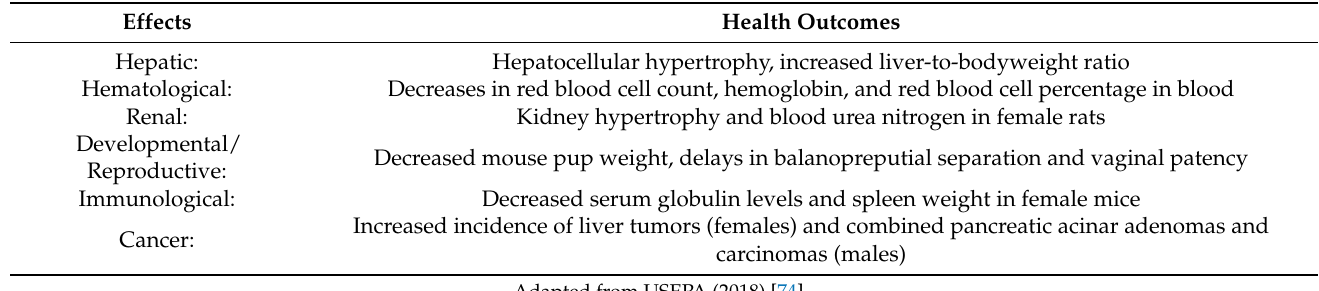
Table 4. Hazard Summary of GenX Chemicals in Rat and Mice